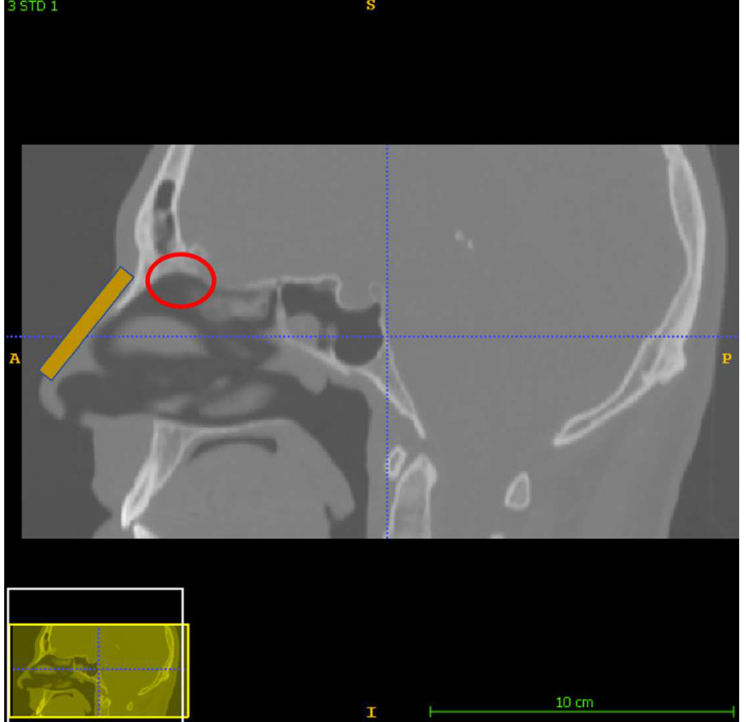
Figure 1. The general layout of the protocols analyzed. A permanent magnet is placed on the nasal septum (orange). The red circle indicates the olfactory region which occupies about 8% of the total nasal passage surface.